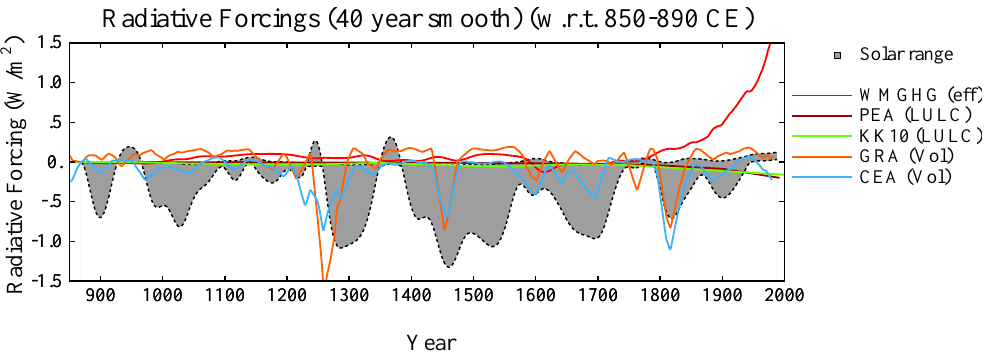
Fig. 4. Estimated radiative forcings for each driver (solar and volcanic forcings are smoothed using a 40yr triangular filter). WMGHG = Well Mixed Greenhouse Gases; GRA = Gao et al. (2008); CEA = Crowley et al. (2008). complexity show much greater variance in temperatures